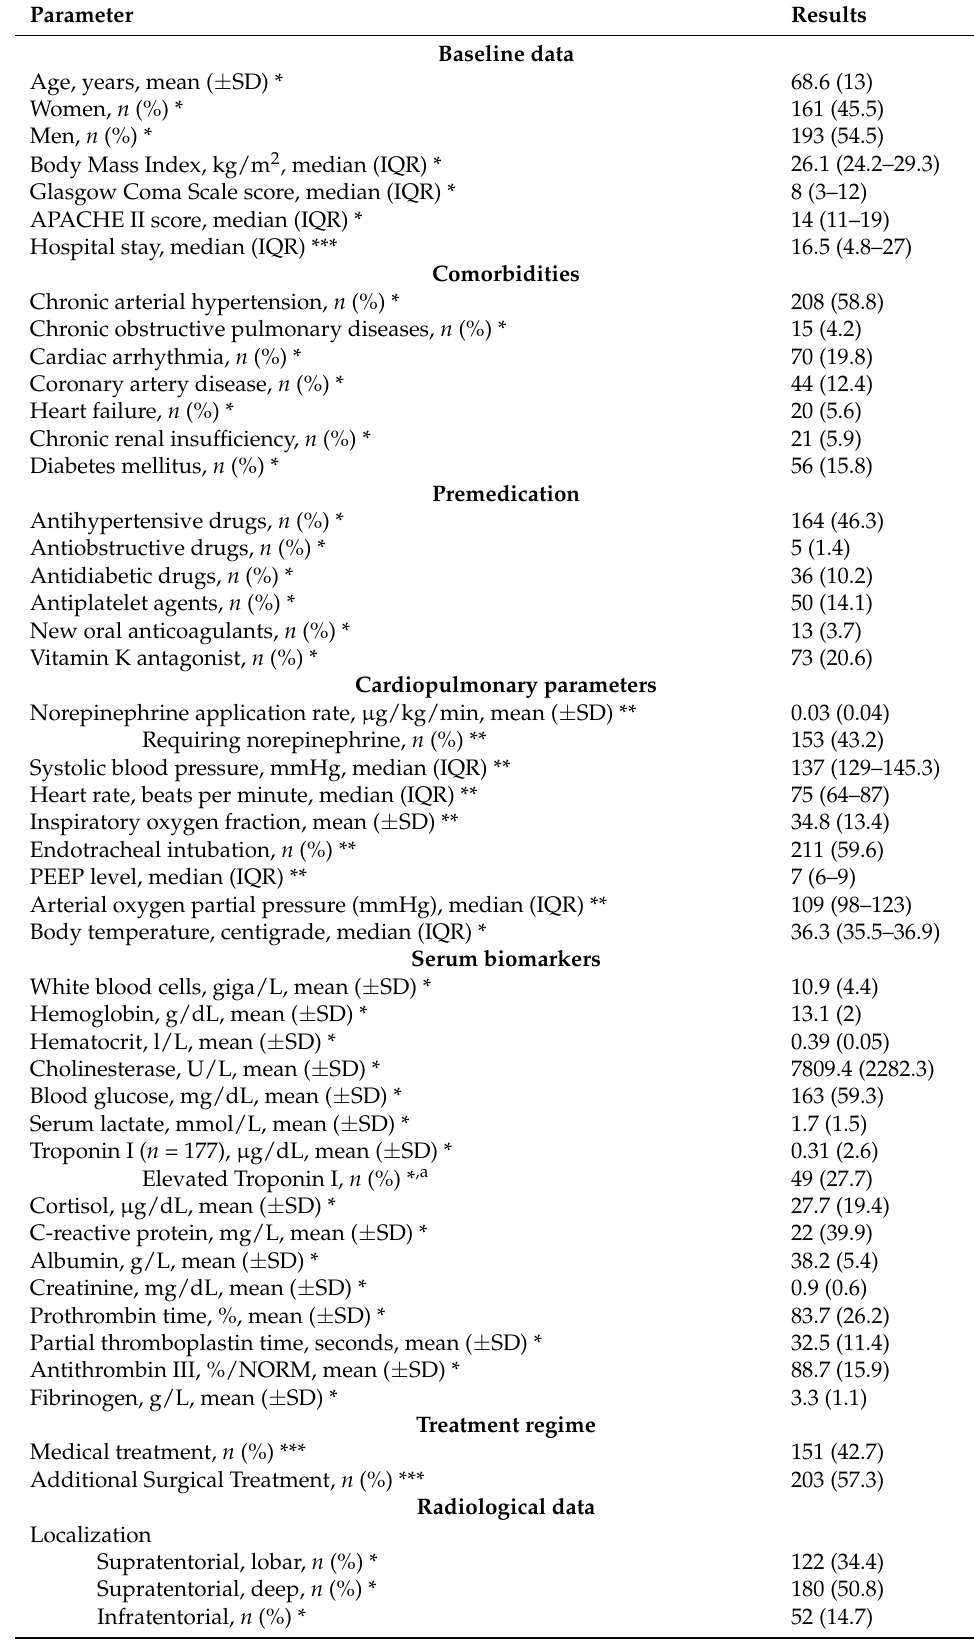
Table 1. Main characteristics of the entire study population ( n =